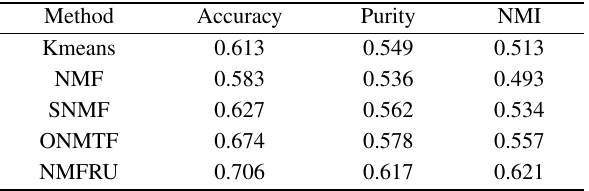
Table 2 Performance results of classifiers.